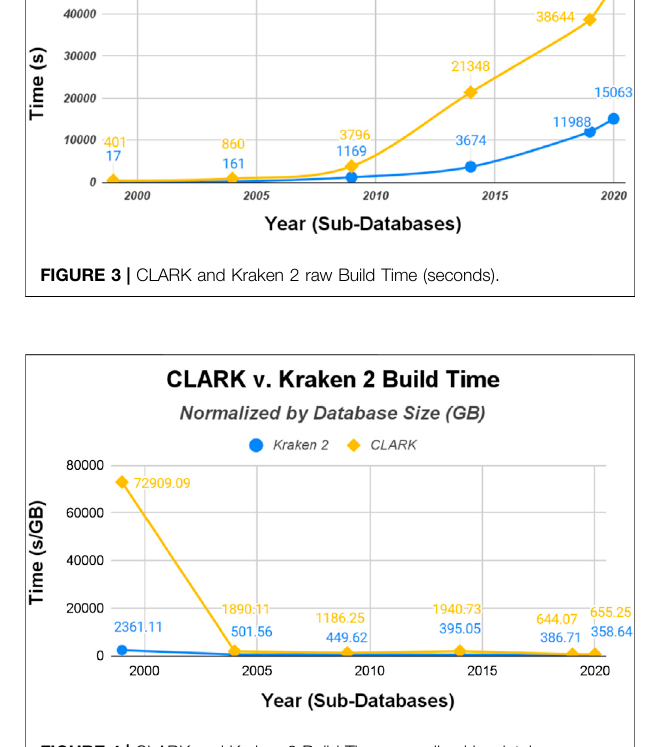
FIGURE 4 | CLARK and Kraken 2 Build Time normalized by database size (seconds/Gigabyte).